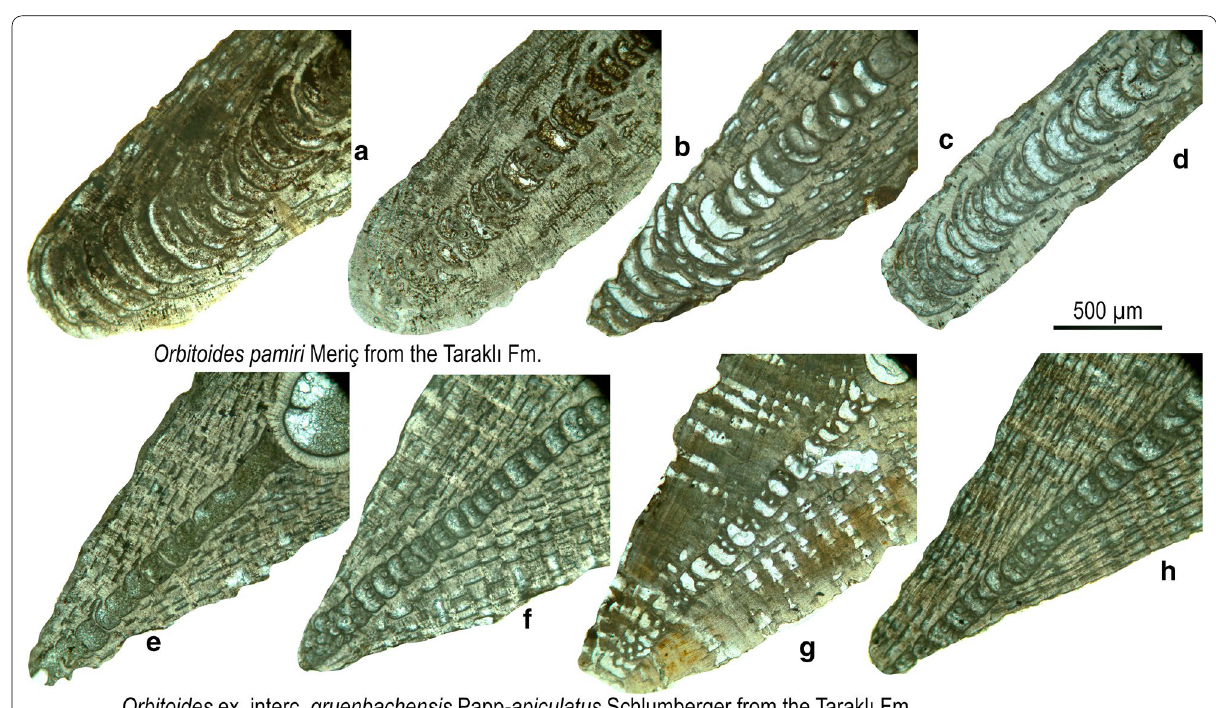
Fig. 13 Comparison of the equatorial layers of O. pamiri Meriç ( a – d ) and O. ex. interc. gruenbachensis Papp– apiculatus Schlumberger ( e – h ) in the axial sections from the Taraklı Formation. Note the high equatorial chamberlets with numerous large stolons in O. pamiri , which are much higher than those of O. ex. interc. gruenbachensis Papp– apiculatus Schlumberger . a EPB1-8. b EPB5-32. c EPB6- 45. d EPB5-4. e EPA14-33. f EPA16-10. g DE7-23. h